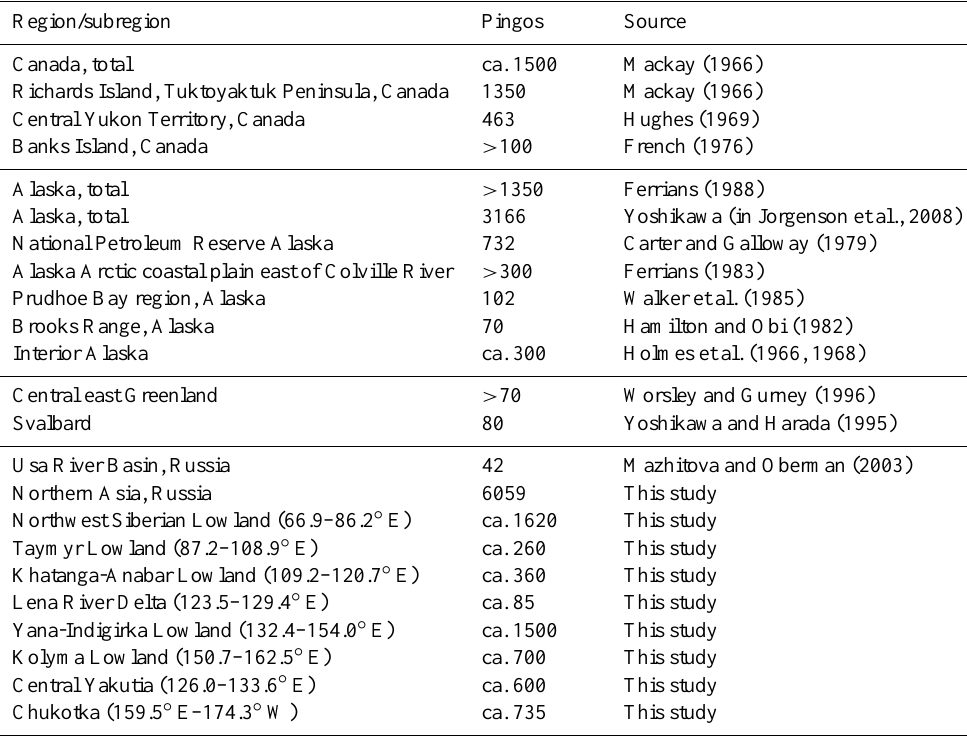
Table 5. Selection of pingo regions and number of detected